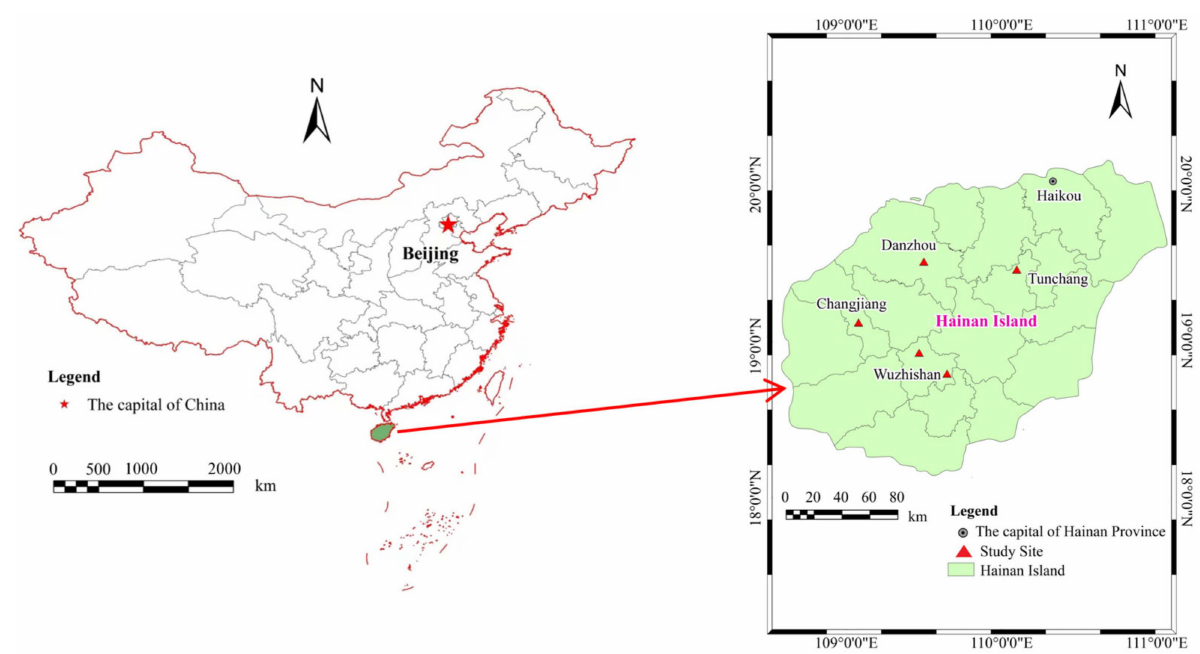
Figure 1. Location of the study area. Danzhou, Tunchang, Changjiang, and Wuzhishan on Hainan Island were selected as the sampling points. There were two sampling points in Wuzhishan, resulting in a total of five sampling